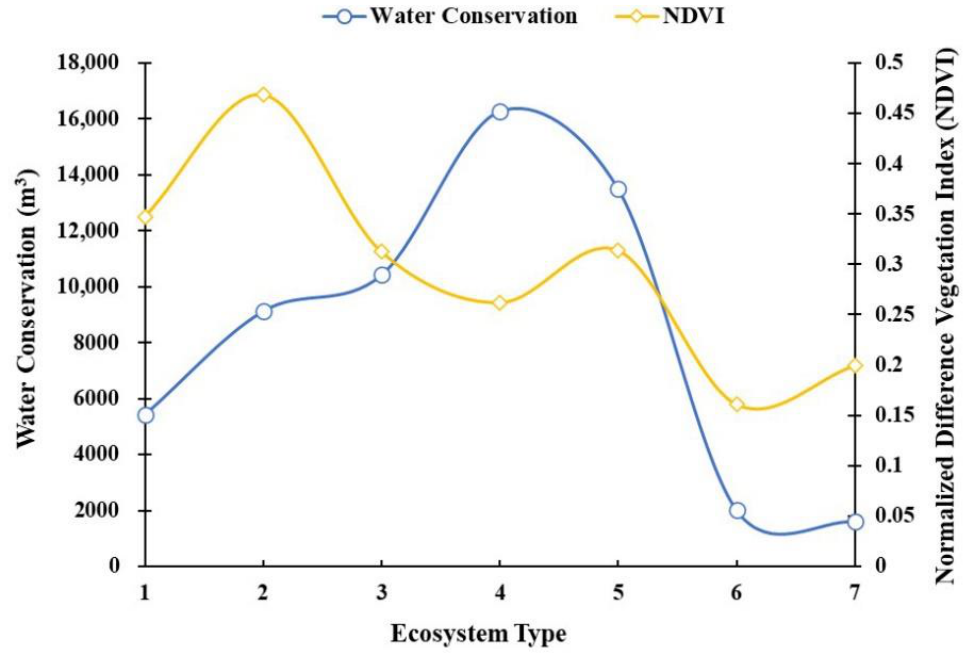
Table 2. Factor detector between water conservation and ecosystem type.